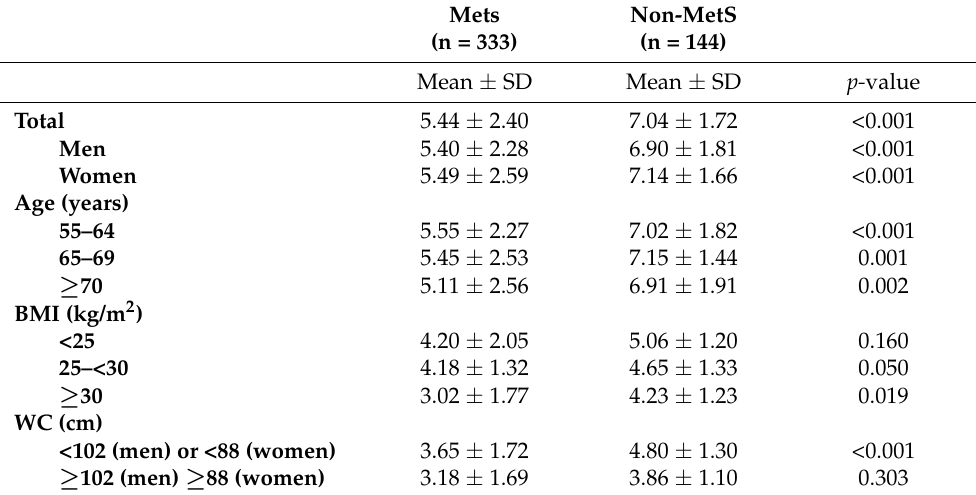
Table 4. Functional Fitness Score considering a sex and age specific cut-off value for functional